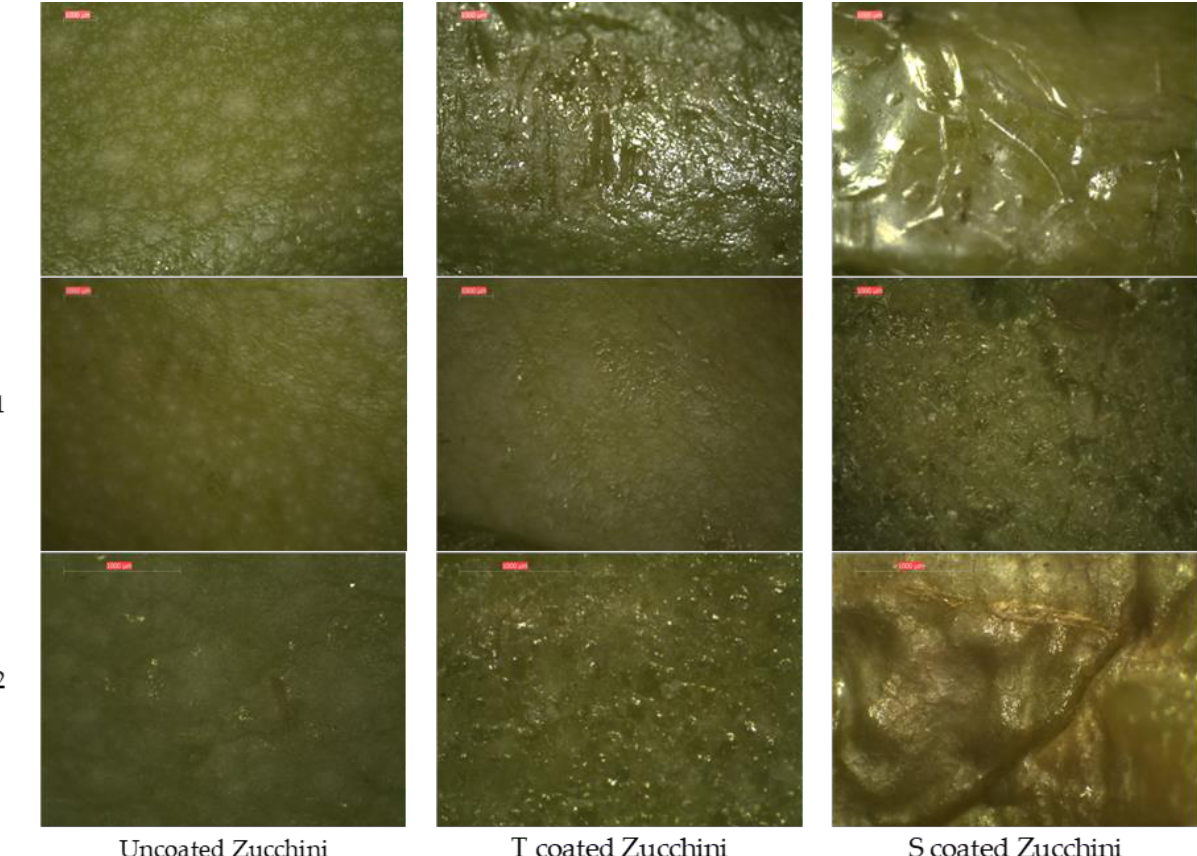
Figure 10. Zucchini peel magnified by stereomicroscope.